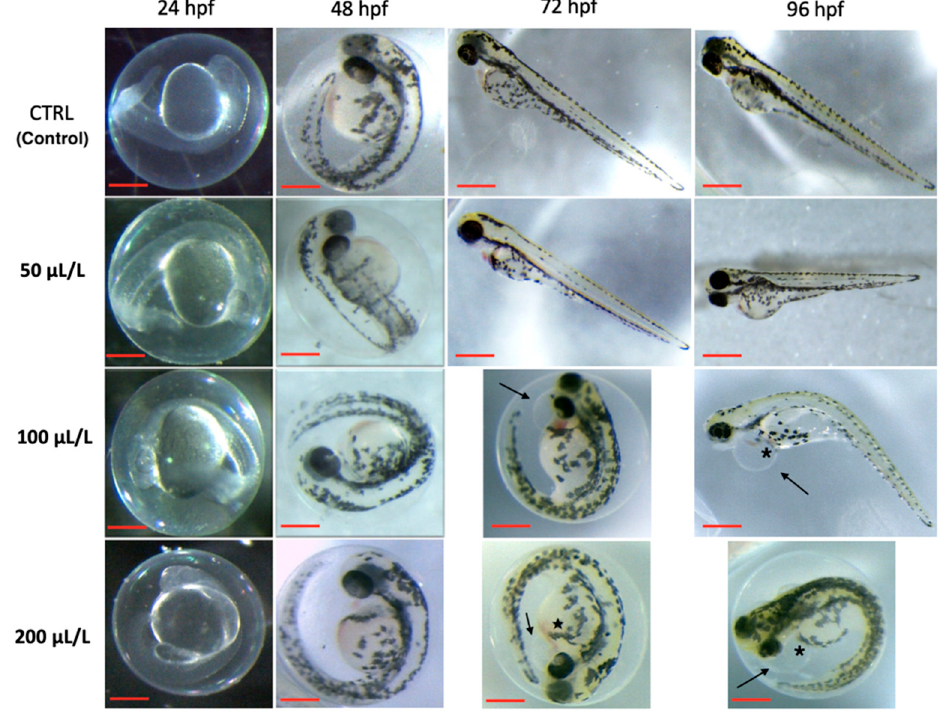
Figure 1. Zebrafish embryos development up to 96 hpf (hours post-fertilization) during exposure to O. basilicum. Pericardial edema (arrow); un-looped heart (asterisk); blood congestion (star). Scale bar 500 μ m.